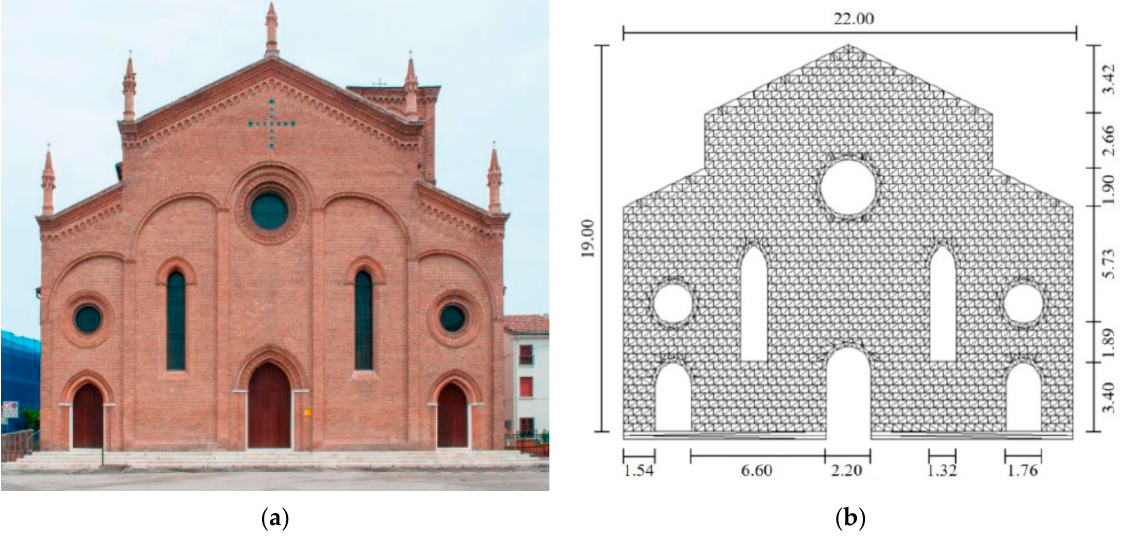
Figure 5. Configurations of the church façade: ( a ) site view [22] (Reprinted/adapted with permission from Ref. [22]. 2022, Elsevier.) and ( b ) geometry (unit: m) and FDEM mesh. Table 1. Material properties of the church façade.